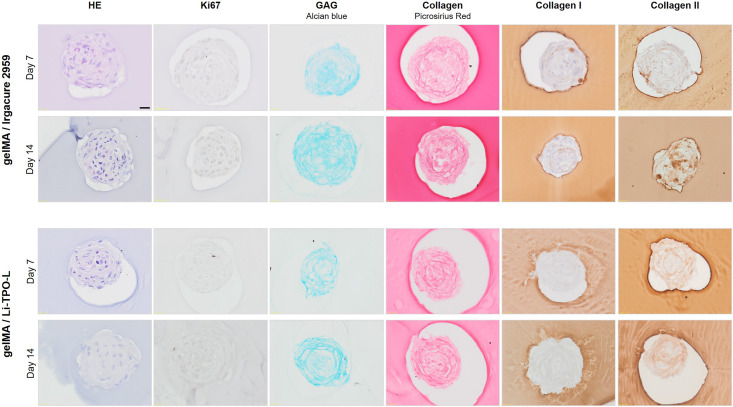
Evaluation of cartilaginous phenotype 7 and 14 days post encapsulation in gelMA. Comparison of Irgacure 2959 or Li-TPO-L as a photo-initiator. HE staining was performed to assess overall morphology, IHC staining for Ki67 indicated proliferating cells, Alcian Blue staining showed the presence of glycosaminoglycans (GAG). Collagen was visualized by Picrosirius Red (PSR) staining and IHC stainings for collagen type I and type II were performed. Scale bar 20 μm.